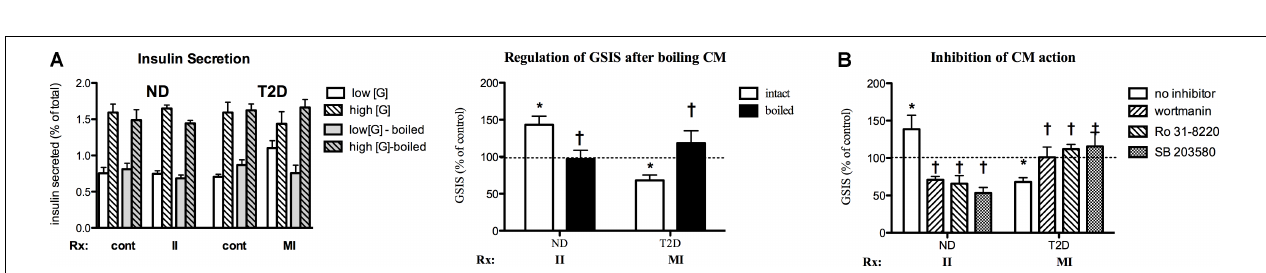
FIGURE 8 | Characterization of MT-CM regulation of GSIS. (A) Cells treated for 24 with intact MT-CM or MT-CM boiled before exposure: Left panel – insulin secretion, Right panel – GSIS ( n = 10). (B) Inhibition. Cells treated with the indicated CM in the absence or presence of SB203580 (100 nM, n = 6 for ND/5 for T2D), Ro 31-8220 (50 nM, n = 6/5), or wortmannin (100 nM, n = 6/8) before GSIS determined. Control = RPMI: α MEM (3:1) w/o treatment conditioned by MT from the same individual. * p < 0.05 vs. matched control, † p < 0.05 vs. intact media (A) or no inhibitor (B) .